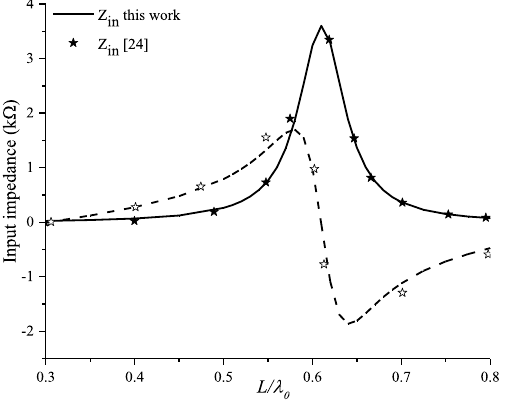
Figure 5. Isotropic input impedance, real and imaginary